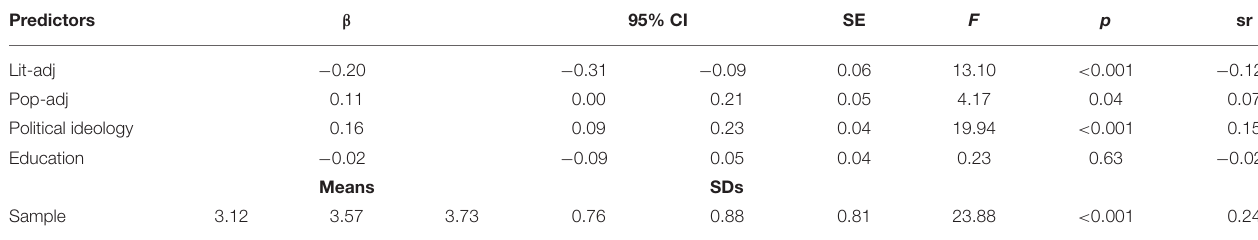
TABLE 3 | Multiple regression results using discreteness as criterion (Study 1). Predictors